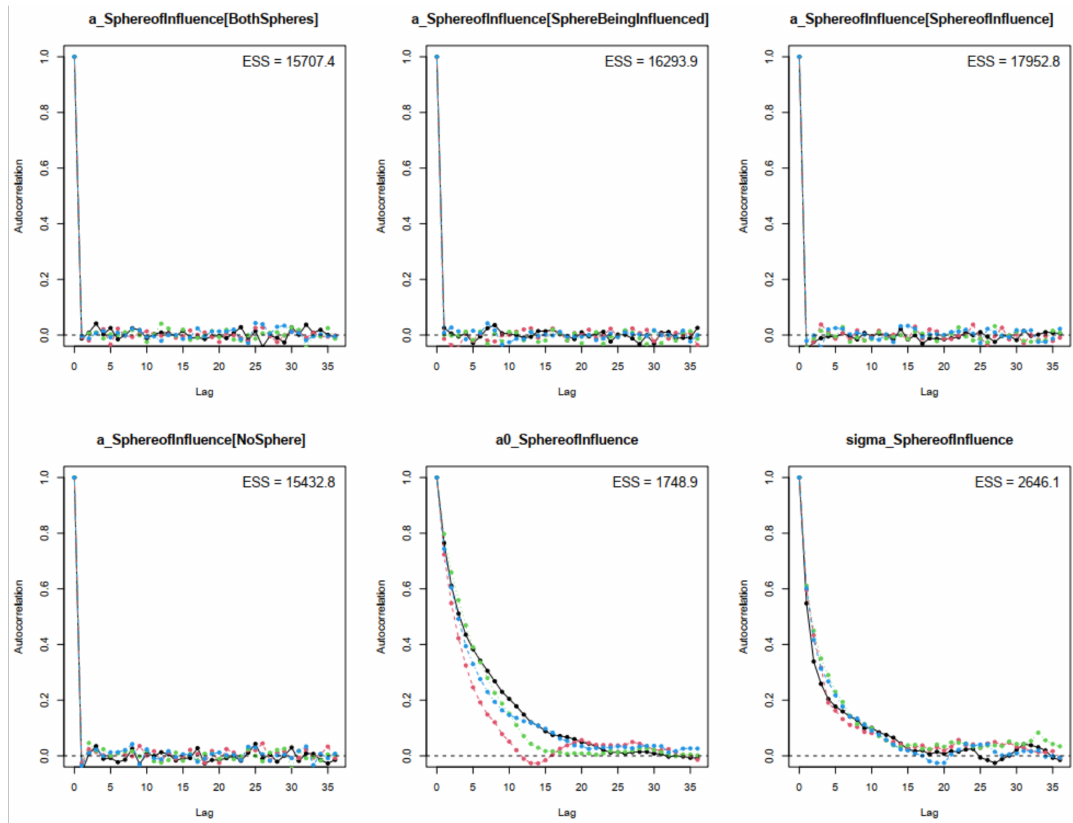
Figure A15. Model 5 (cid:48) s autocorrelation